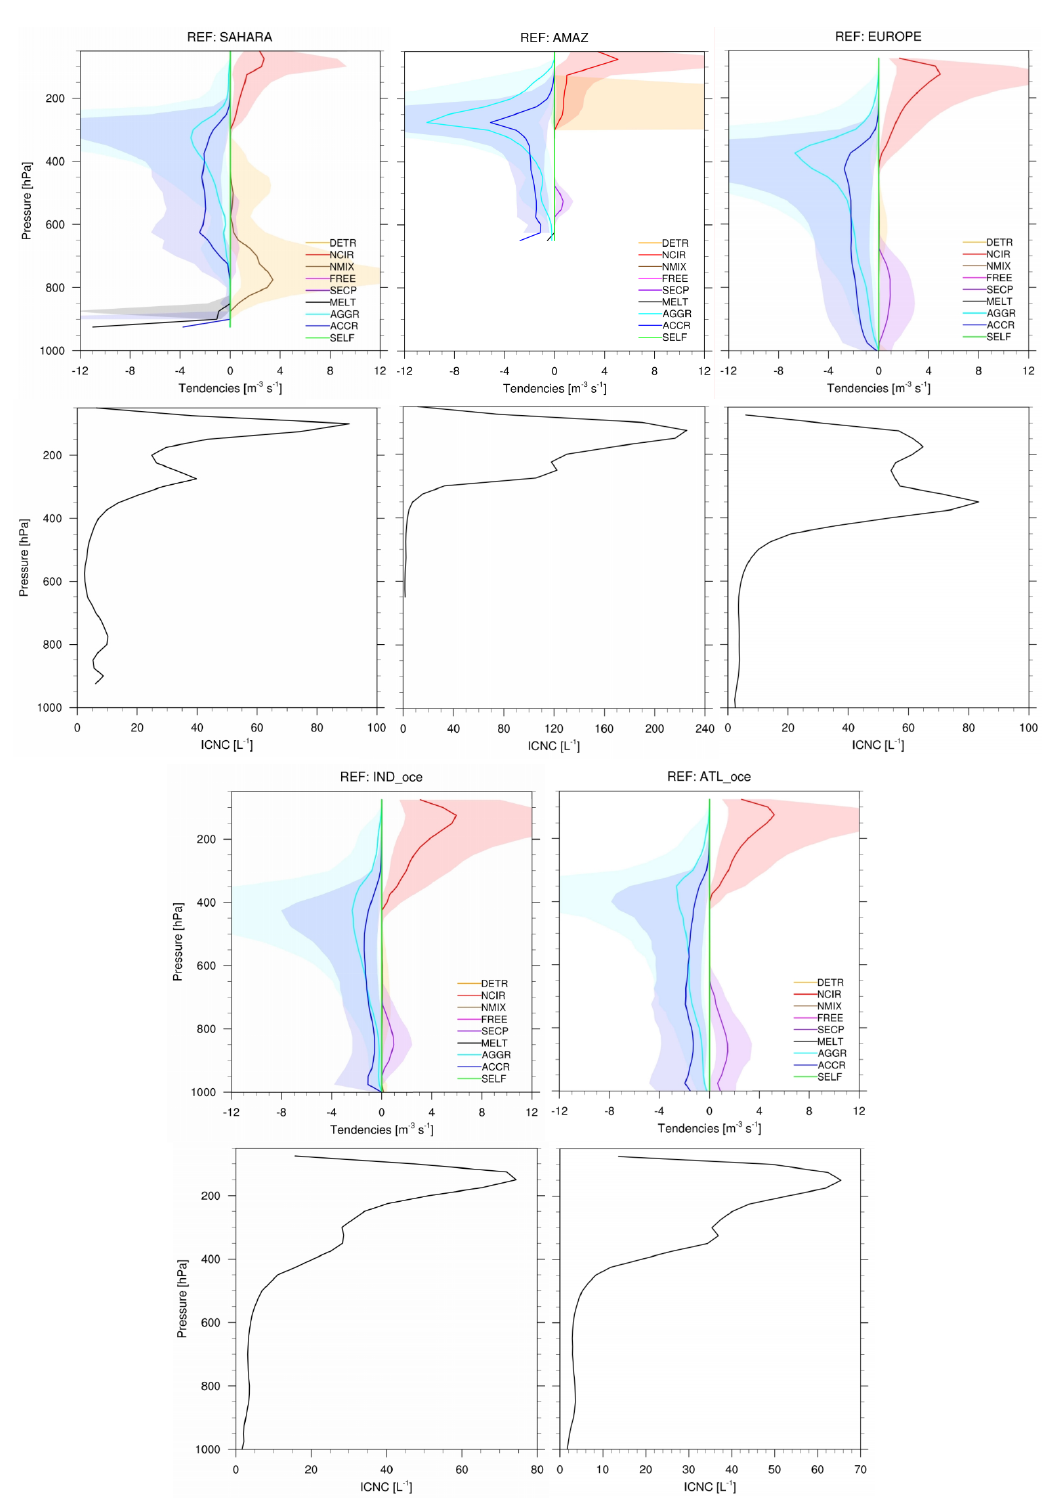
Figure 8. Microphysical process tendencies and ICNC as a function of pressure computed for different regions: Amazon, Sahara, central Europe, southern Indian Ocean, and North Atlantic Ocean. The vertical profiles are medians computed only where ICNC > 1L − 1 in bins of 25hPa. The coloured shadows mark the areas between the 25th and the 75th